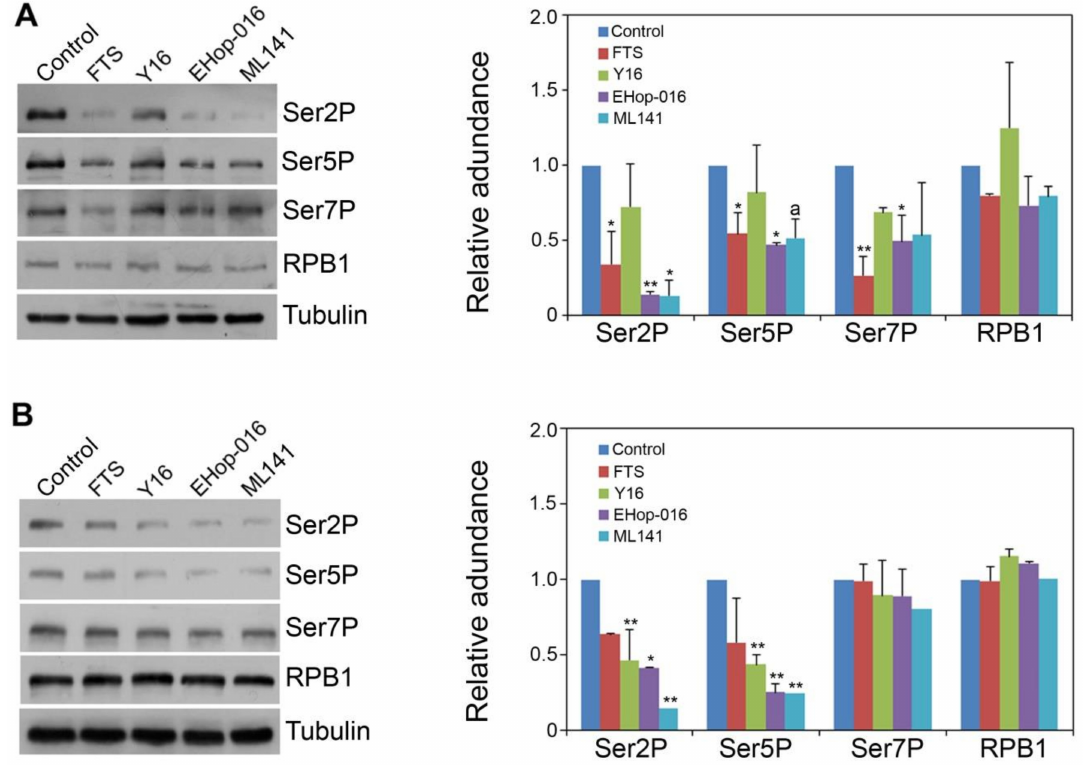
Figure 1. Inhibitors of small GTPases reduced CTD Ser2P and Ser5P levels. Cells were treated with various inhibitors for 48 hr, and the proteins were analyzed by Western blot using Ser5P-, Ser2P- and Ser7P-specific antibodies. ( A ) HeLa cells. ( B ) DU145 cells. FTS, farnesylthiosalicylic acid, a Ras antagonist. Y16, a RhoA inhibitor. Ehop-016, a Rac1 and Rac3 inhibitor. ML141, a Cdc42 inhibitor. Tubulin, the protein loading control. Quantitative analysis of the Western blot results from two independent biological replicates was shown. Protein level in the control was set as 1.0. Significance level is indicated by * ( p < 0.05) or ** ( p < 0.01) vs. control. The letter a above the column indicates a marginal di ff erence ( p <